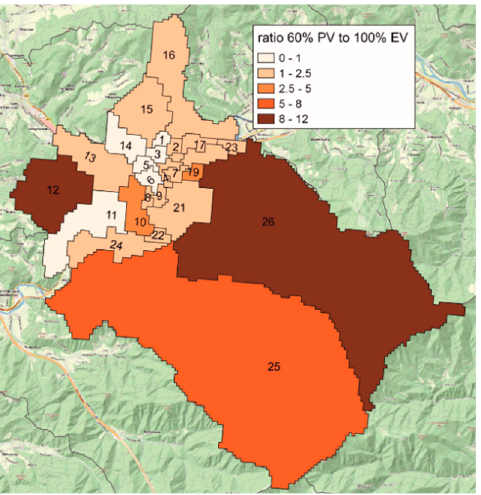
Figure 20. Energetic ratio of the annual energy production of 60% PV potential to the annual energy demand of 100% EV.